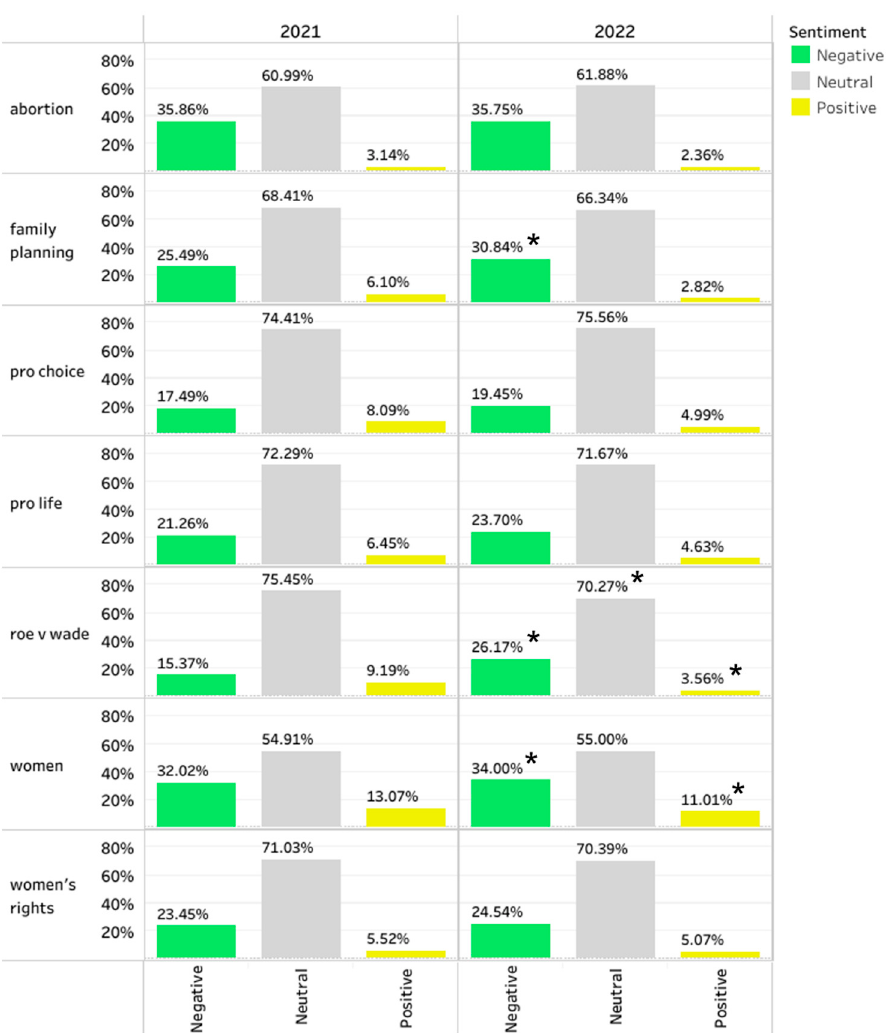
Figure 7. Topic categories by sentiment, 1 May–15 July in 2021 and 2022 . * p < 0.002 for Bonferroni corrected t-tests comparing 2021 vs. 2022 sentiment.